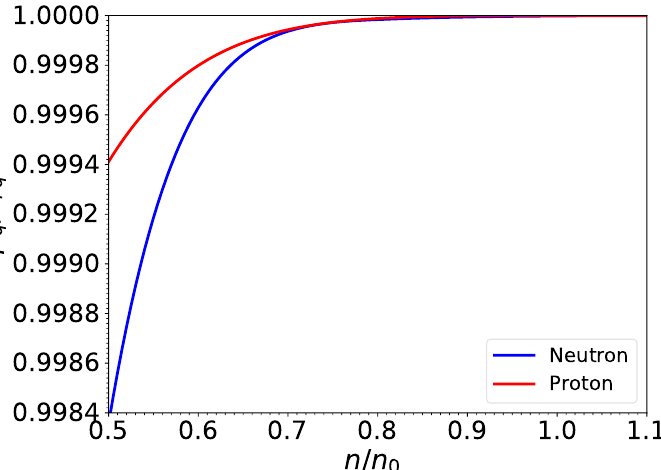
Figure 6. Reduced chemical potentials µ q relative to the corresponding Fermi energy for npe µ matter in beta-equilibrium at baryon densities prevailing in neutron-star cores in units of the saturation density n 0 . Results obtained at T = 0 and for V q =